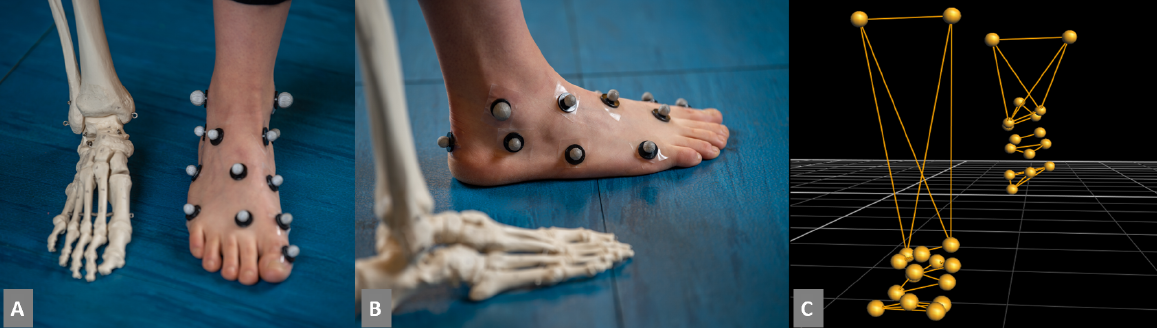
Figure 1. ( A ) and ( B ) Photograph of reflective marker locations on a participant’s feet, and ( C ) Single frame image of reconstructed three-dimensional marker trajectories from the Vicon motion capture system.